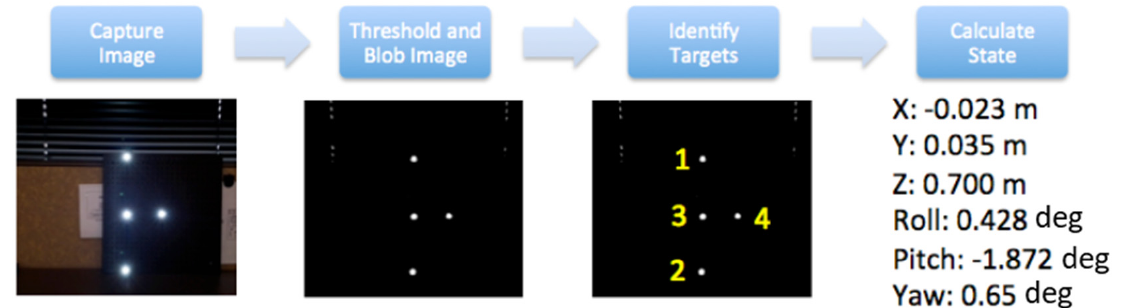
Figure 4. SVGS algorithm flow [18,19], and example output vector.